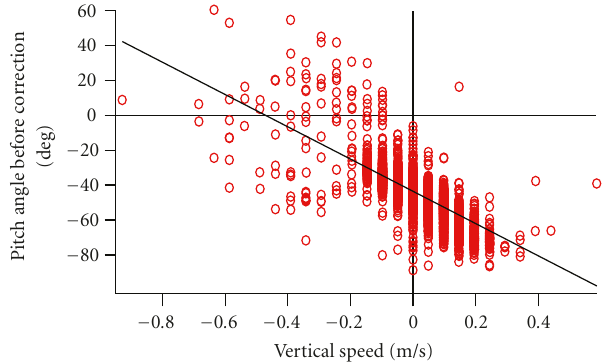
Figure 3: Example of the relationship between raw pitch angle ( γ ) and vertical speed from an individual pup (HI0702). A negative vertical speed indicates ascent and a positive value indicates